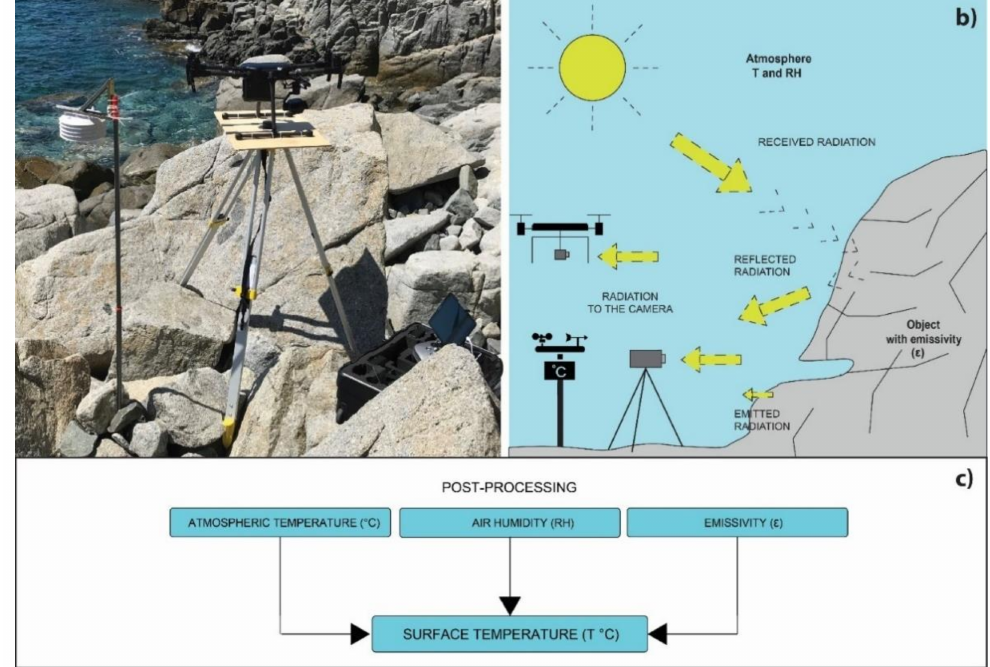
Figure 3. ( a ) Drone and weather station; ( b ) schematic of the acquisition system (a ground-based solution was adopted in this work) and heat transfers between the cliff and the atmosphere [16]; ( c ) post-processing